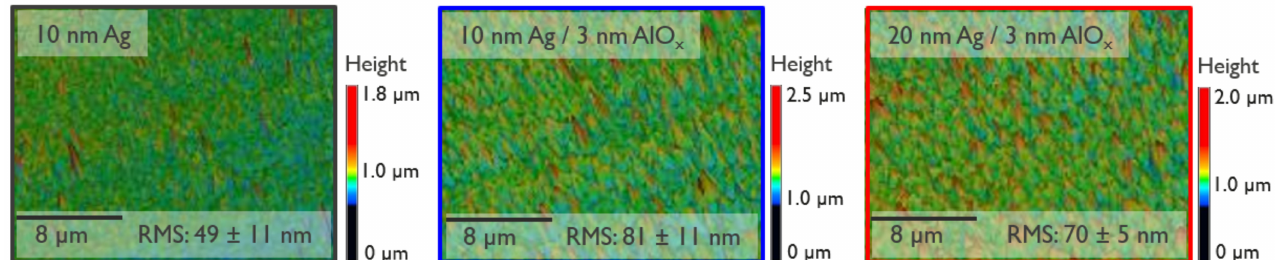
Figure 9. Confocal microscopic images of the bare absorber layers. The height variations are enhanced seven times. The given RMS values are averaged over five line measurements.